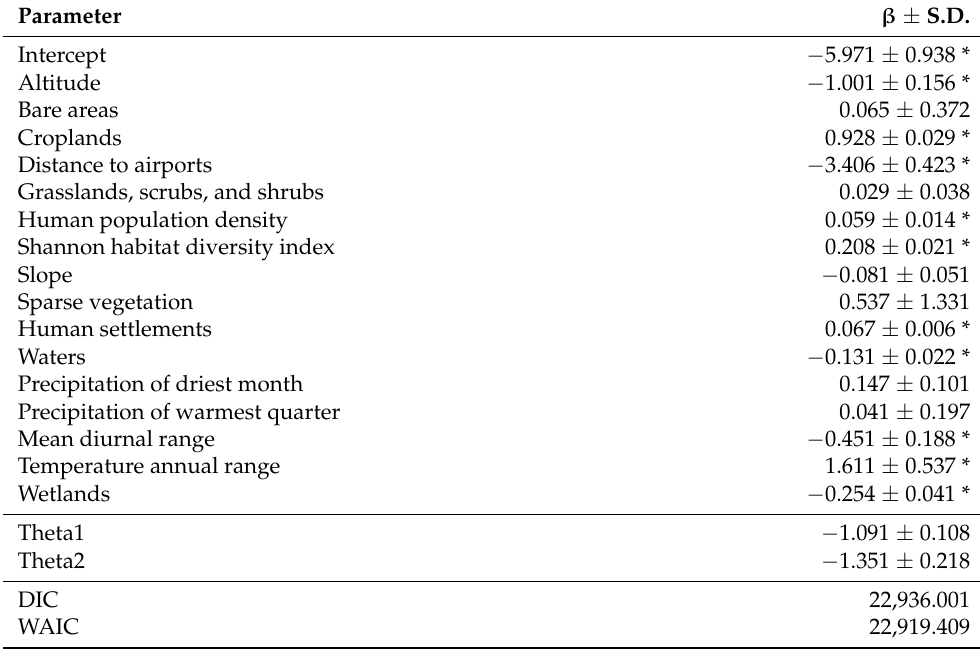
Table 2. Average coefficients ( β ) ± standard deviation (S.D.) and significance (*, different from 0) of the predictors considered to model Japanese beetle occurrence in INLA SPDE. Thetas for the spatial random effect, deviance information criterion (DIC), and Watanabe–Akaike information criterion (WAIC) are also shown.